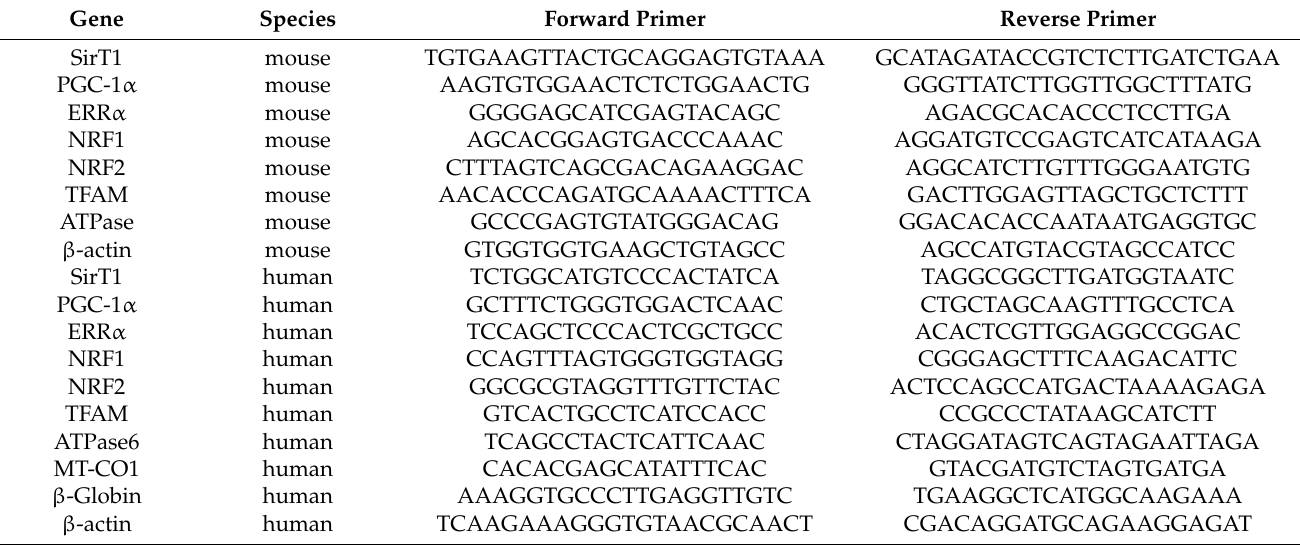
Table 1. Quantitative real-time PCR